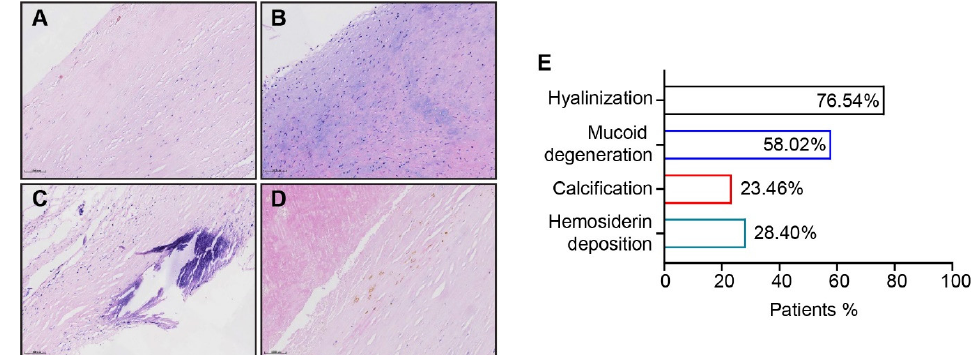
Figure 3. The remodeling of the vascular extracellular matrix in PEA-removed tissues from CTEPH patients. ( A – D ) Representative images of hyalinization ( A ), mucoid degeneration ( B ) , calcification ( C ), and hemosiderin deposition ( D ) in HE staining. ( E ) Distribution of ECM alteration in the CTEPH patient population. Scale bar = 100 μ m. 3.3. Atherosclerotic Lesion Formation Corresponds with Main Pulmonary Artery Dilation in